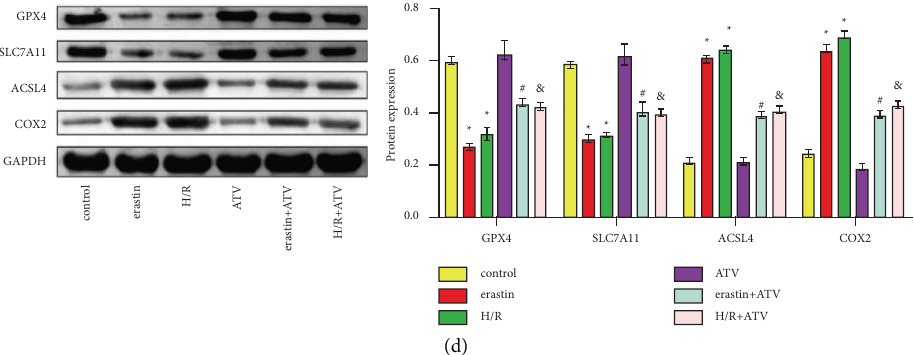
Figure 1: ATV inhibited the ferroptosis of H9C2 cells. (a). CCK8 was performed to measure cell vitality. (b). TEM was conducted to observe mitochondrial morphology. Magnifcation � 10k and Scale bar � 1.0 μ m. (c). ROS level was detected by DCFH-DA solution and C11- BODIPY fuorescent probe in H9C2 cells with diferent treatments. (d). Protein expression was tested by WB. ∗ P < 0 . 05 vs. the control group. # P < 0 . 05 vs. the erastin group. And P < 0 . 05 vs. the H/R